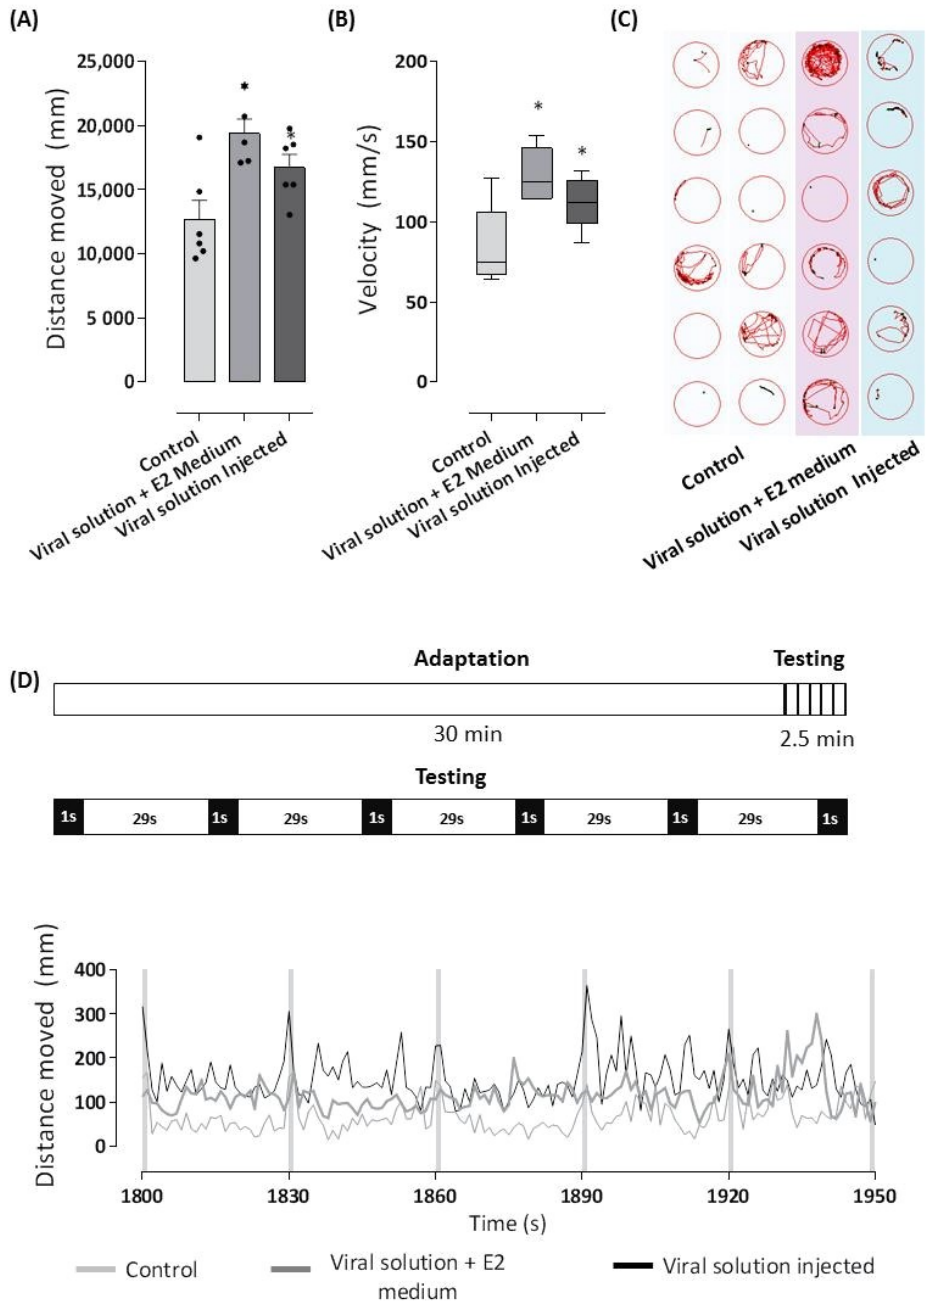
Figure 4. ZIKV replicated in zebrafish was able to infect healthy larvae. The supernatants obtained after centrifugation of the lysate from the 72 hpf ZIKV-infected larvae or control larvae were injected in 72 hpf healthy larvae into the yolk (2 nL) or diluted in E2 0.5 × medium (0.04%). After 24 h, larvae were distributed in a 96-well plate (1 larvae/well), and the locomotor activity was analyzed in Zebrabox system. The larvae were exposed to an incubation period of 30 min in the light (lux: 12%) followed by the testing phase consisting of a dark stimulus (lux: 0%) for 1s, alternated by 29s in the light (lux: 12%) for 2.5 min to induce visual stimulation and the startle response. The total distance moved (mm) of each group during the testing period and the average velocity (mm/s) of each group are shown in ( A , B ). Graphical representation of the larvae tracking during the testing phase ( C ). The lines represent the distance moved by the larvae at each second during the total experiment period with highlights of testing phase ( D ). * p < 0.05 compared with the negative control group.